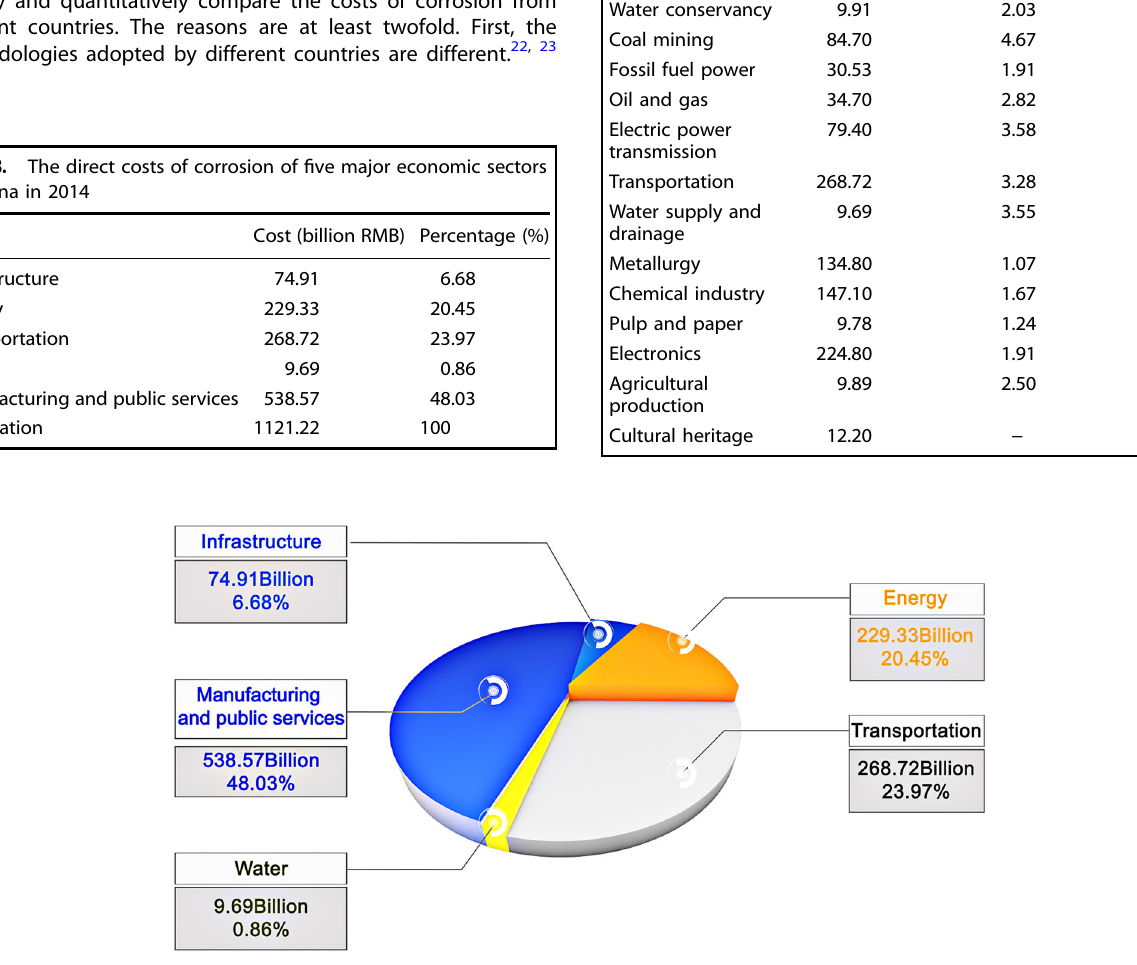
Fig. 2 The direct costs of corrosion of fi ve major economic sectors in China in 2014